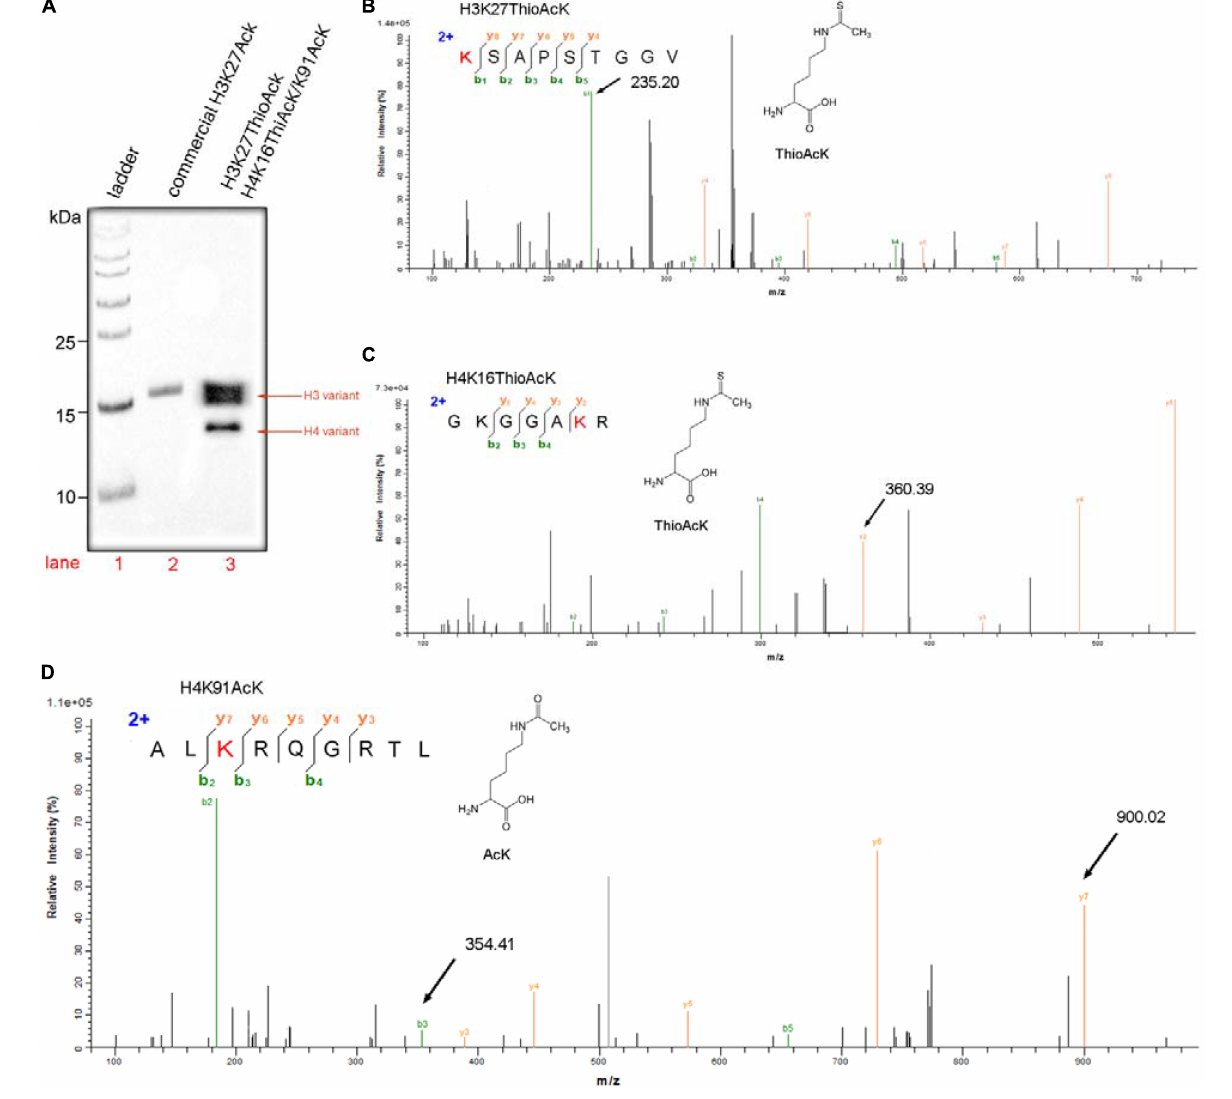
FIGURE 3 | One-pot incorporation multiple ThioAcK and AcK residues into histone H3 and H4 variants (H3K27_ThioAcK and H4K16_ThioAcK/K91_AcK). (A) Western Blots of multiple PTMs on H3 and H4 with the site-specifically anti-ackyl histone antibodies (H3K27, H4K16 and H4K91). 10 µ L of the corresponding PURE reaction solution was loaded. Lane 1: commercial protein marker as ladder. (B) MS/MS spectra of tryptic peptideK (ThioAcK) SAPSTGGV digestion for H3K27_ThioAcK at the site of K27. (C) MS/MS spectra of tryptic peptides GKGGAK (ThioAcK) R digestion at K16 of the K16 ThioAcK and (D) ALK(AcK)RQGRTL digestion at K91 of the